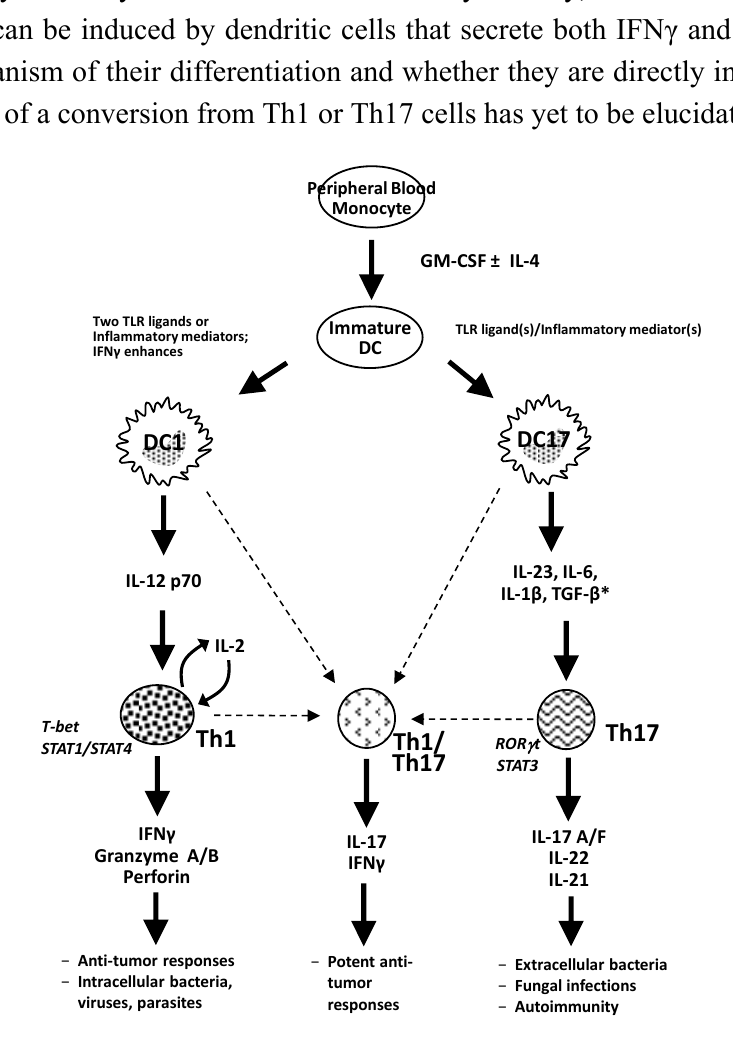
Figure 1. Dendritic cell induced Th1 and Th17 immune responses. Toll-like receptor (TLR) ligands are used to mature dendritic cells, and depending on the ligand(s)